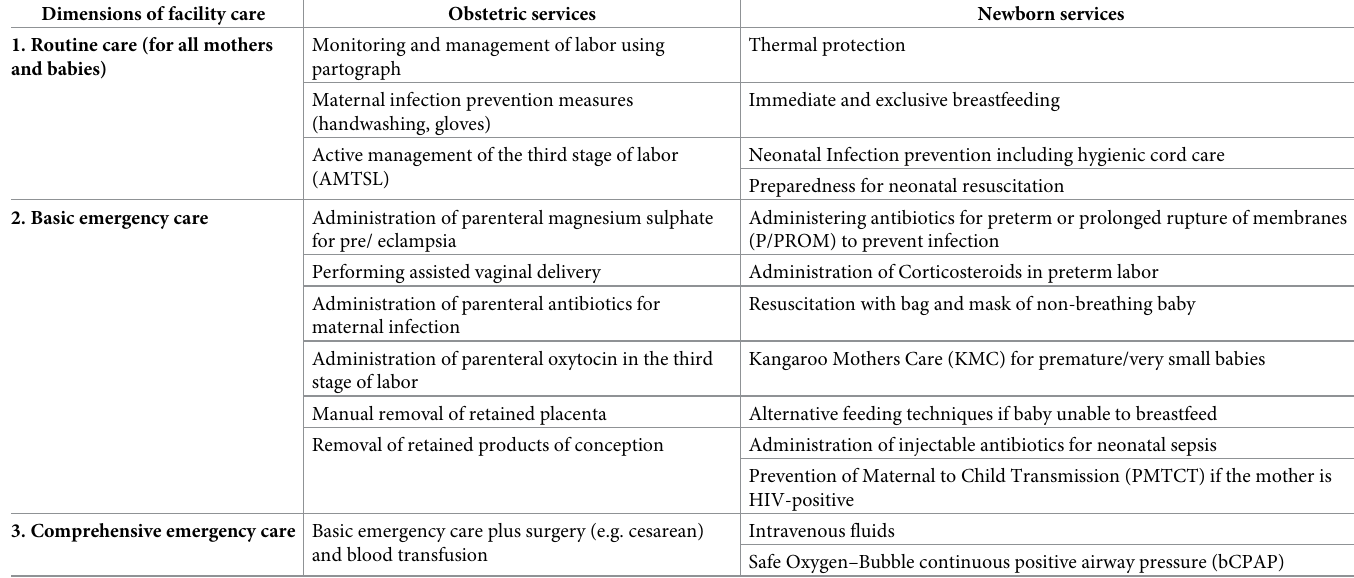
Table 1. Essential maternal and newborn care interventions for routine care, basic and comprehensive emergency obstetric and newborn care [10, 11, 13]. Dimensions of facility